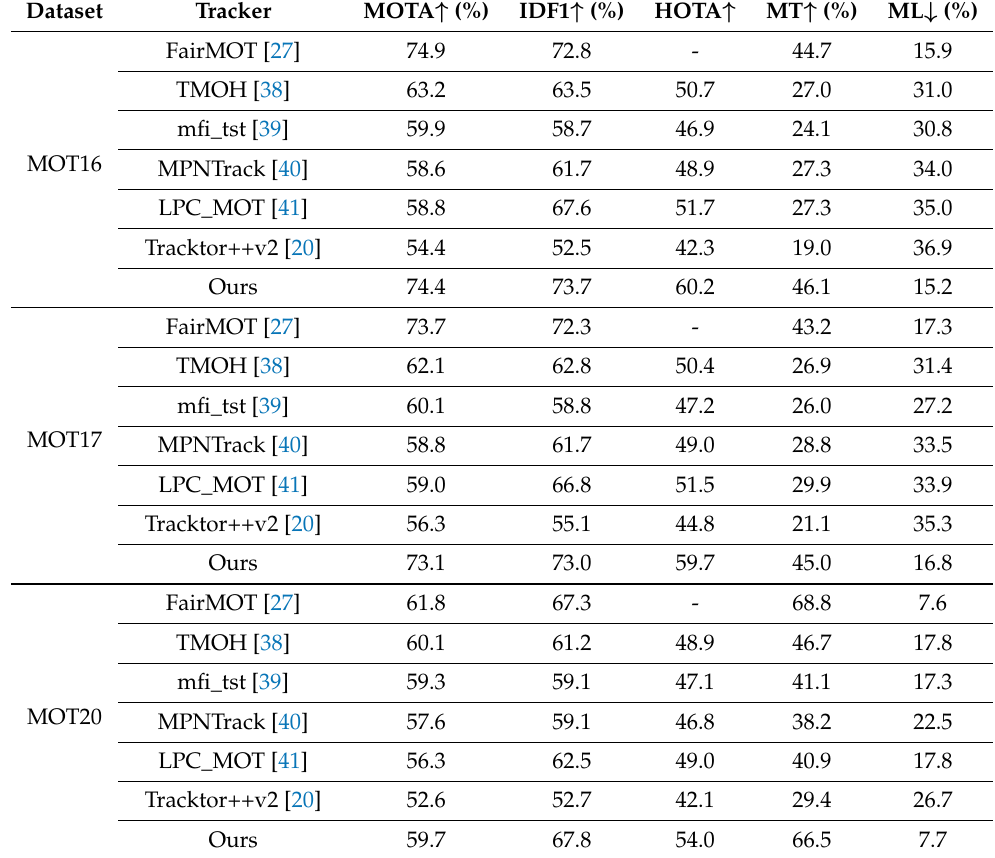
Table 1. Comparison of the state-of-the-art methods on the Multiple Object Tracking Benchmark. Dataset